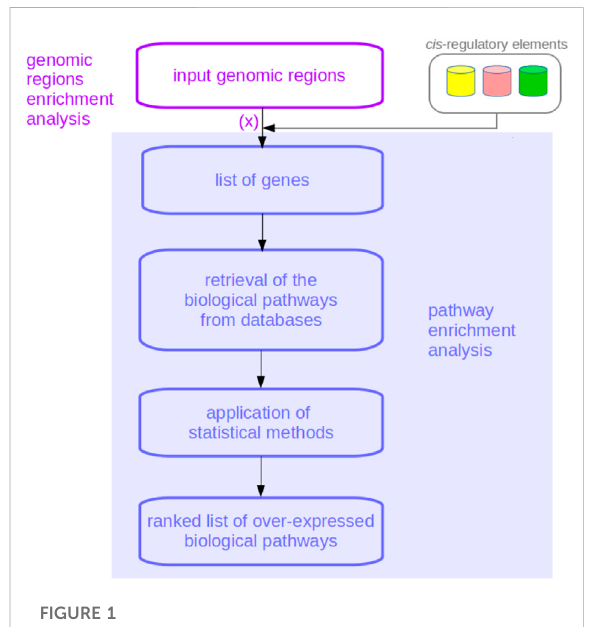
FIGURE 1 Flowchart of a genomic regions enrichment analysis. The associationofthegenescorrespondingtothequerychromosome regions, here indicated with (x), isthe phase where BEHST,GREAT, LOLA, and Poly-Enrich involve cis -regulatory elements ’ data. As is evident, genomic regions enrichment analyses incorporate pathway enrichment